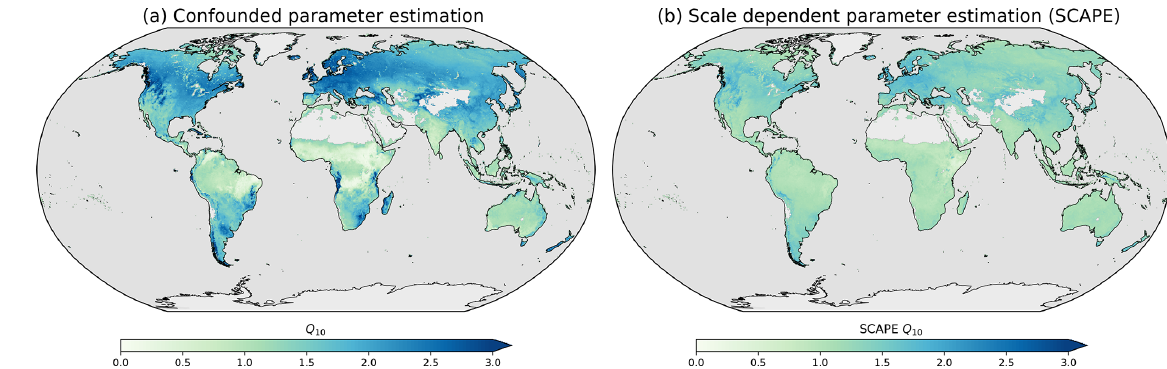
Figure 7. Global patterns of locally estimated temperature sensitivities of ecosystem respiration Q 10 (a) via a conventional parameter esti- mation approach and (b) via a timescale-dependent parameter estimation method. The latter reduces the confounding influence of seasonality and leads to a fairly homogeneous map of temperature